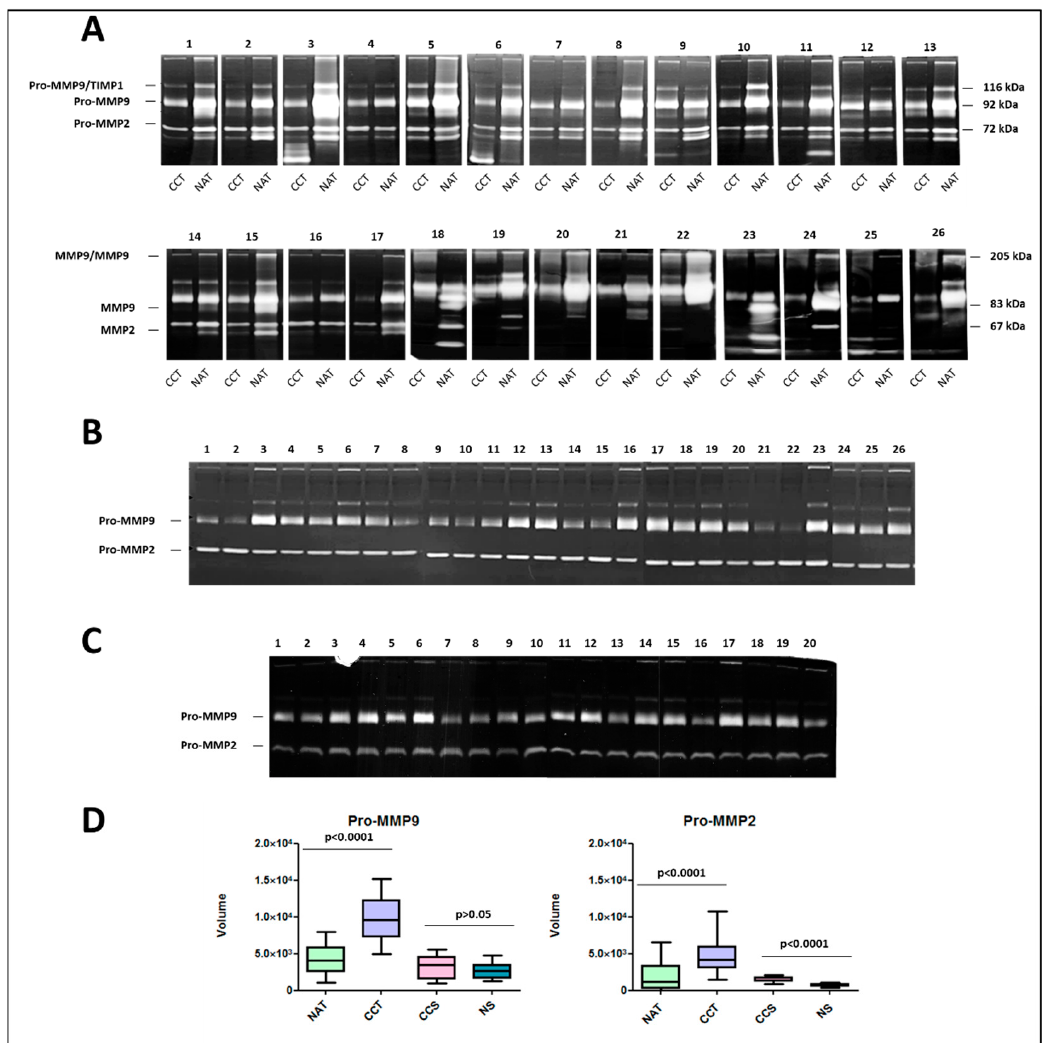
Figure 4. MMP9 and MMP2 activity levels in colon cancer tissues, normal adjacent tissues, and sera. ( A ) Gelatin zymography of protein extracts from 26 colon cancer tissues (CCT) and 26 paired normal adjacent tissues (NAT). ( B ) Gelatin zymography of 26 sera from the same patients, collected before surgery and ( C ) 20 sera from healthy donors. ( D ) Box plot of lytic bands quantification. The experiments were performed in triplicate. p -value indicates statistical significance.